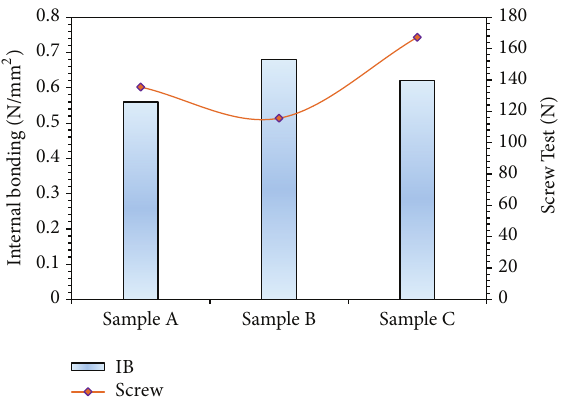
Figure 1: Effect of particles size on Internal Bonding and Screw Test.